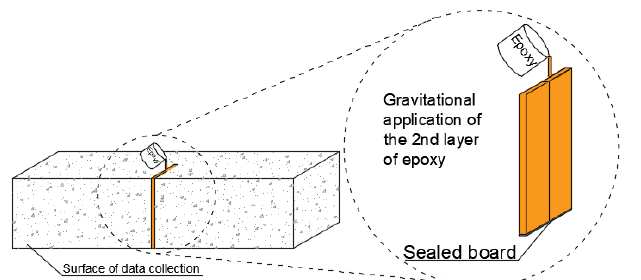
Figure 4. 2 nd stage of resin